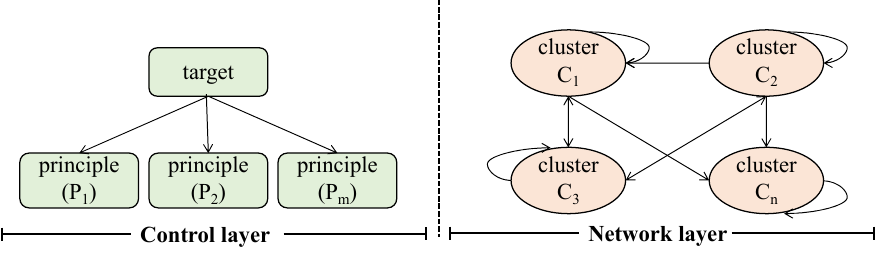
Figure 4. Factors affecting the height of the water-conducting fracture. The ANP model consists of a control layer and network layer, as shown in Figure 5.